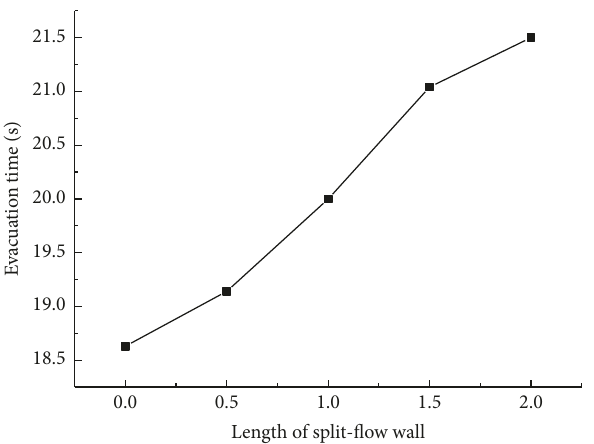
Figure 6: Evacuation time when 𝐷 = 0.5 , 𝜌 = 0.3 .